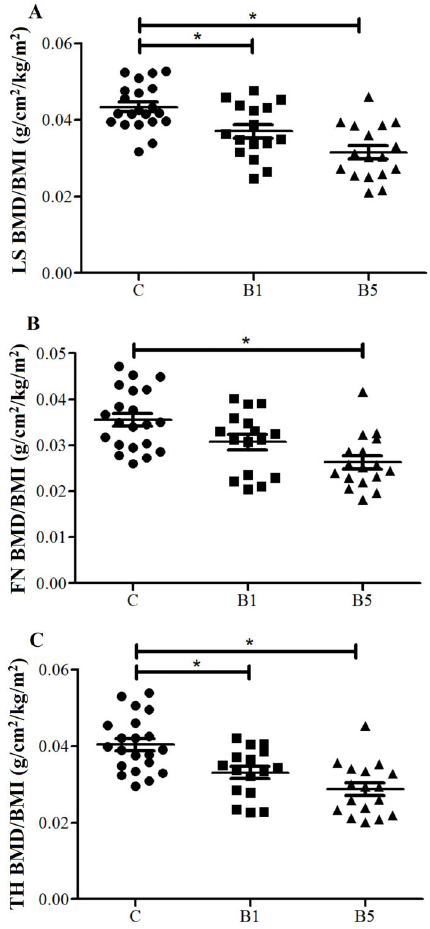
Figure 1. Distribution of ( A ) lumbar spine bone mineral density/ body mass index (LS BMD/BMI) ratio, ( B ) femoral neck bone mineral density/body mass index ratio (FN BMD/BMI) ratio, and ( C ) total hip bone mineral density/body mass index (TH BMD/ BMI) ratio in the control group (C), and obese women evaluated one year (B1) and fi ve (B5) years after Roux-en-Y gastric bypass. Data are reported as means ± SD. *P o 0.05,